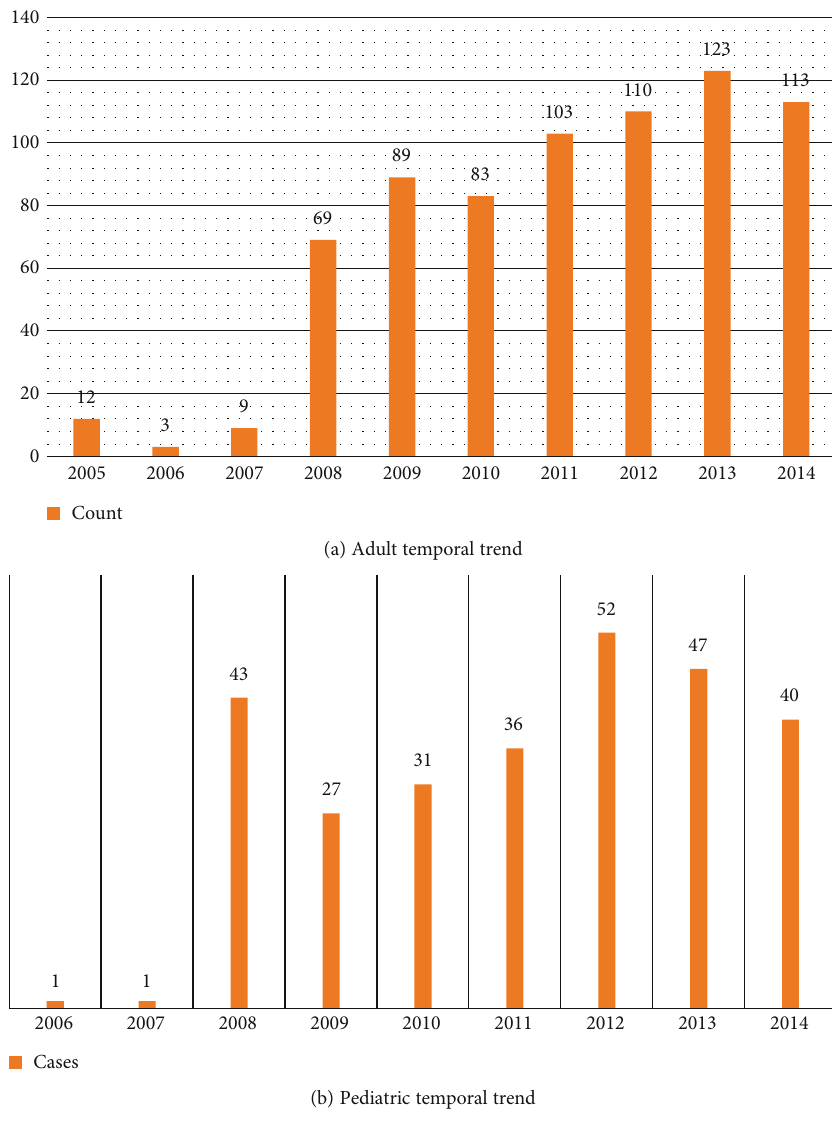
Figure 3: Annual distribution and trend of adult and pediatric primary CNS tumors